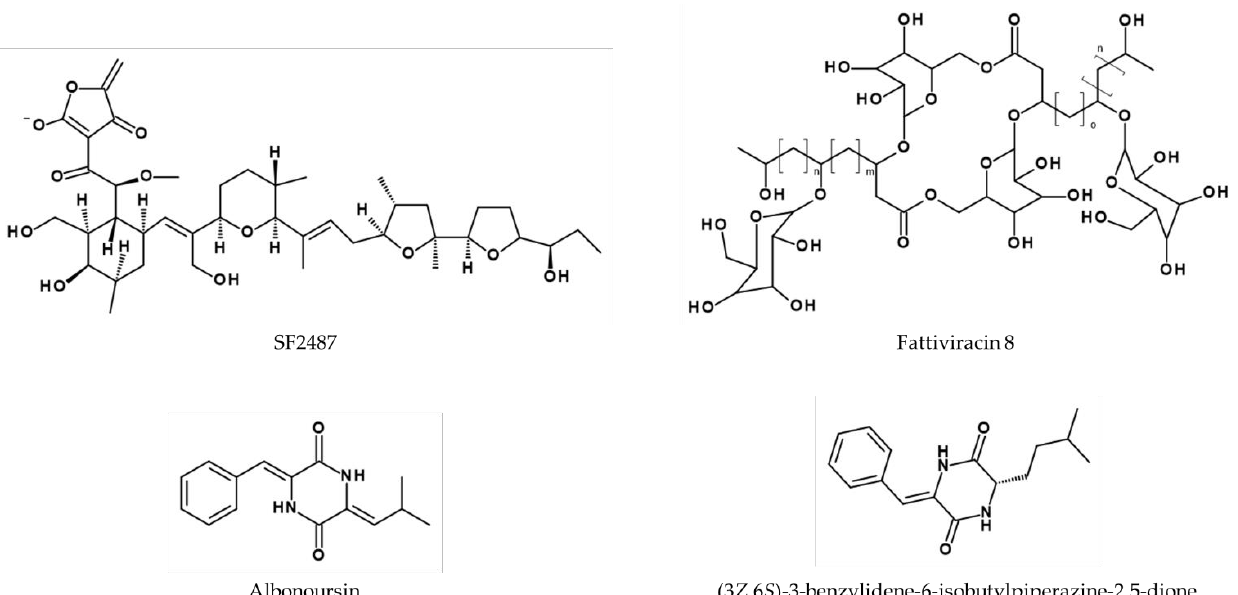
Figure 11. Structure of SF2487 [159] and of fattiviracin 8 with n = 5, m = 13, and o = 11 [160], albonoursin, and (3 Z ,6 S )-3-benzylidene-6-isobutylpiperazine-2,5-dione [163]. The fermentation broth of Streptomyces sp. FXJ7.328 was shown to contain the diketopiperazine derivative (3 Z ,6 Z )-3-(4-hydroxybenzylidene)-6-isobutylidenepipera- zine-2,5-dione. Its activity against A/Puerto Rico/8/34 (H1N1) was compared to the known diketopiperazine derivatives (3 Z ,6 S )-3-benzylidene-6-isobutylpiperazine-2,5-dione, and albonoursin ( Error! Reference source not found. ) in MDCK cells, revealing IC 50 values of 41.5 ± 4.5 µM for the new compound compared to 28.9 ± 2.2 µM for (3 Z ,6 S )-3-benzylidene-